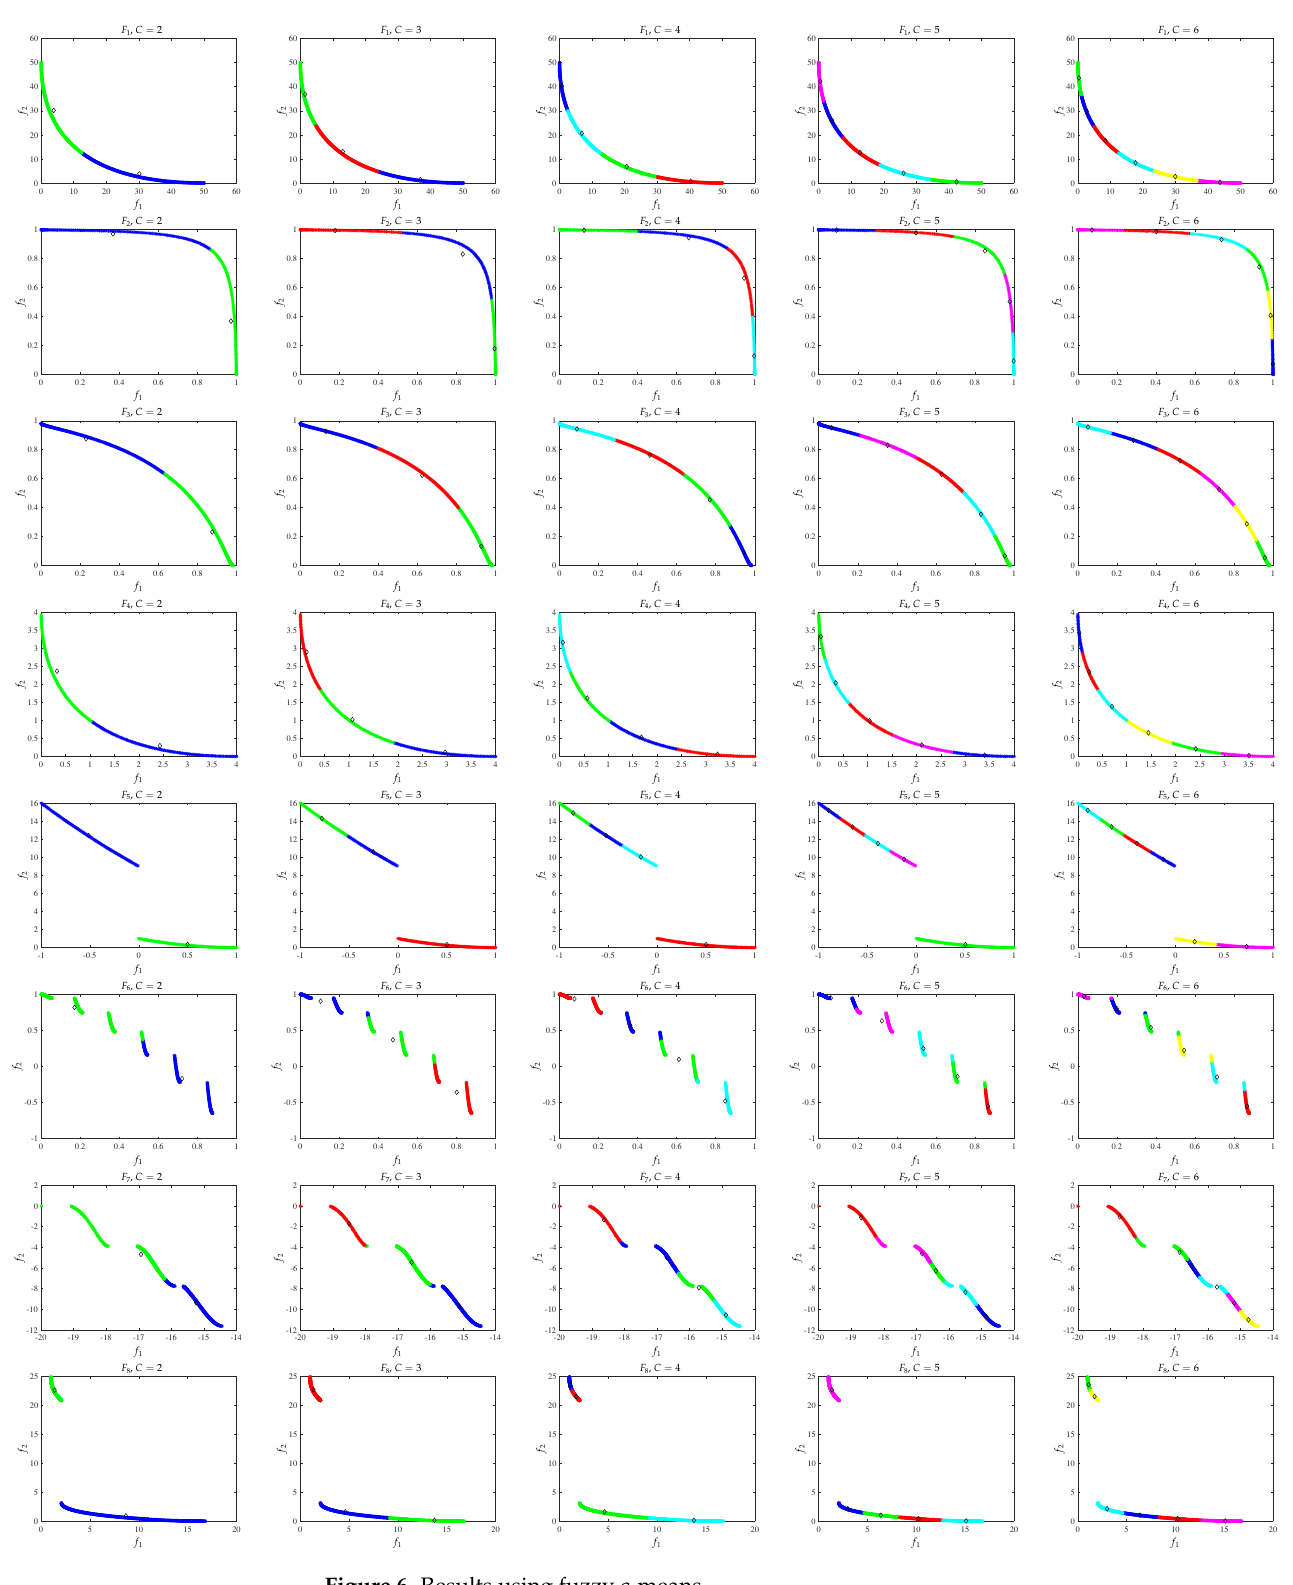
Figure 6. Results using fuzzy